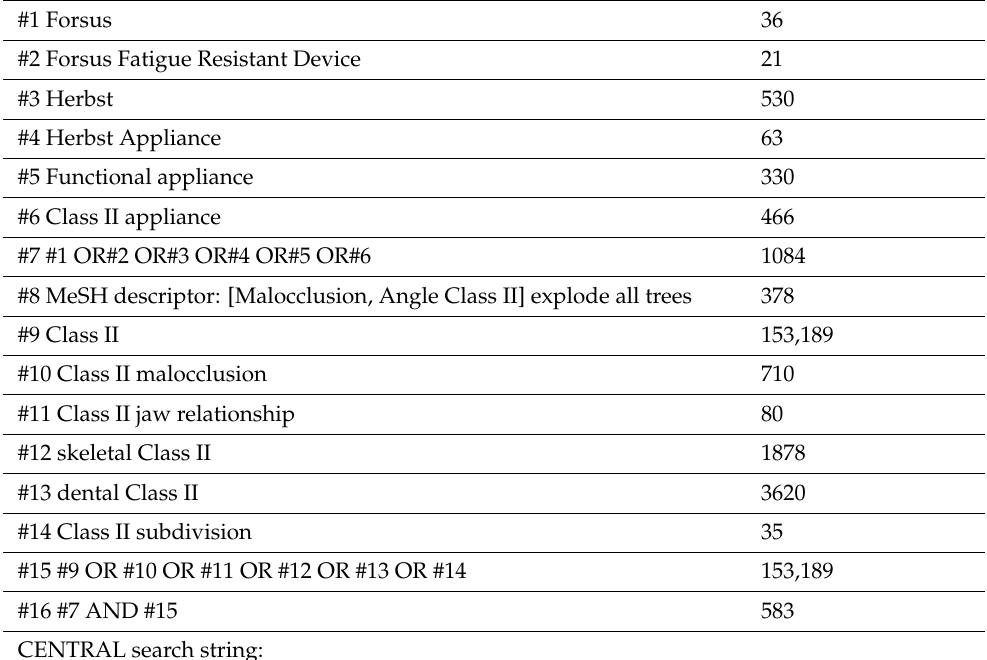
Table A4. Search strategy and search string for CENTRAL.